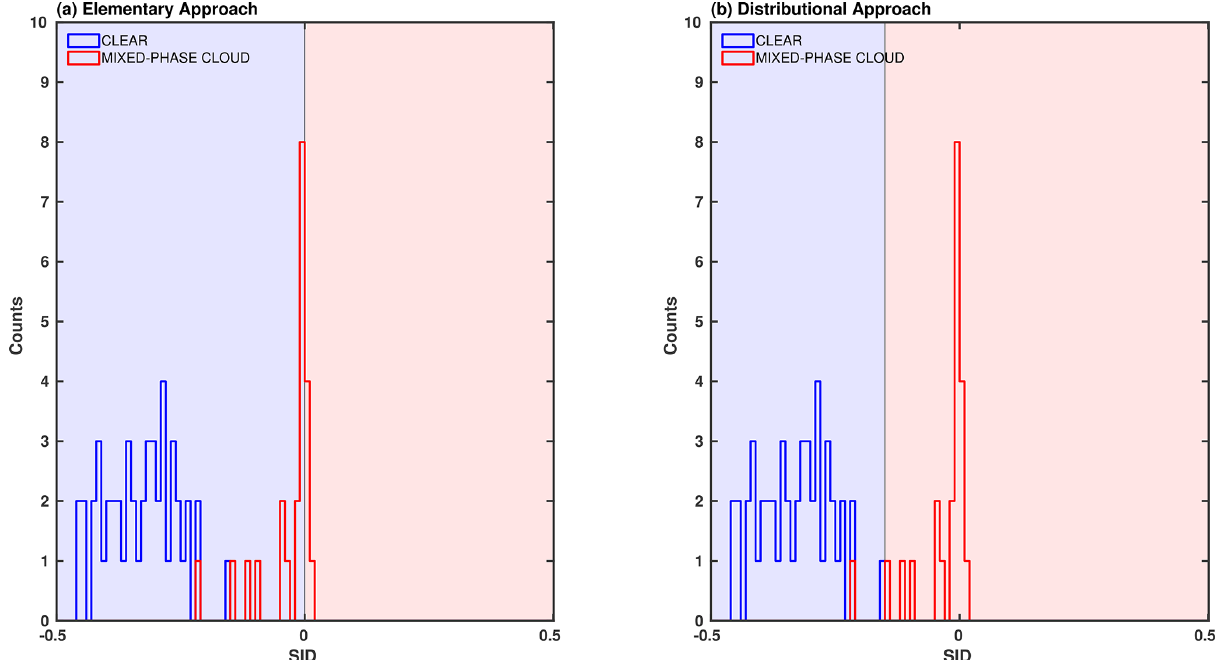
Figure 4. Example of (a) the CIC elementary approach and (b) the distributional approach applied to the training set elements of clear sky (49 spectra) and mixed-phase clouds (22 spectra) in the warm season (November–March). The clear-sky (blue histogram) and the mixed-phase cloud (red histogram) training set elements are classified according to the SID as clear-sky (shaded blue area) or mixed-phase cloud (shaded red area) scenes. Only 76% of the spectra are correctly classified using the elementary approach, while 99% of the spectra are correctly classified using the distributional